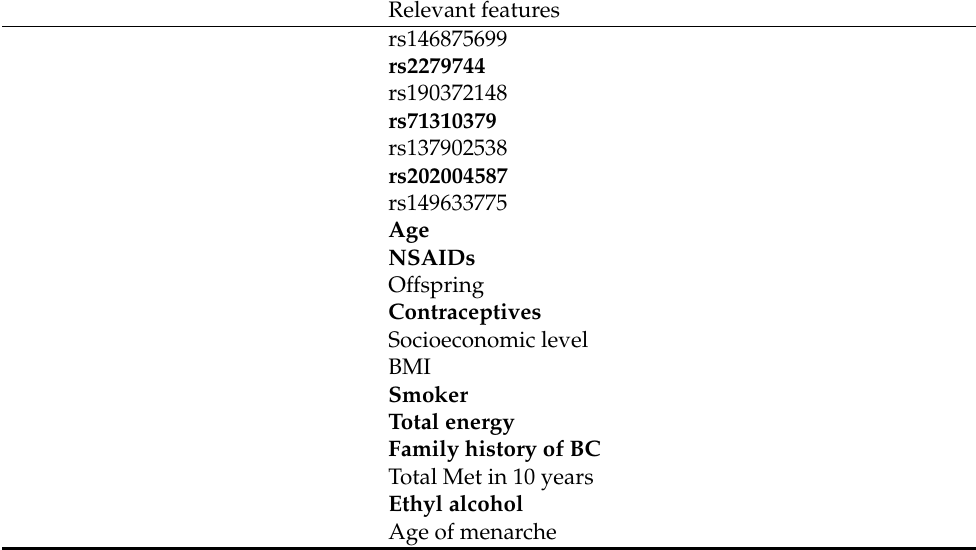
Table 9. Relevant features according to state-of-the-art knowledge. Features highlighted in bold are those that have also been found relevant in our